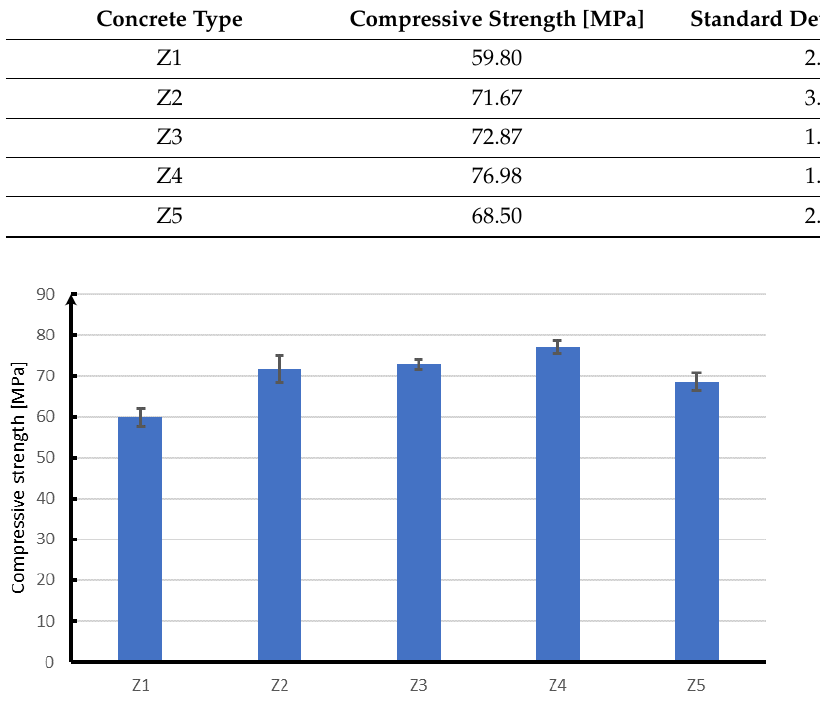
Figure 1 5. Results of the compressive strength